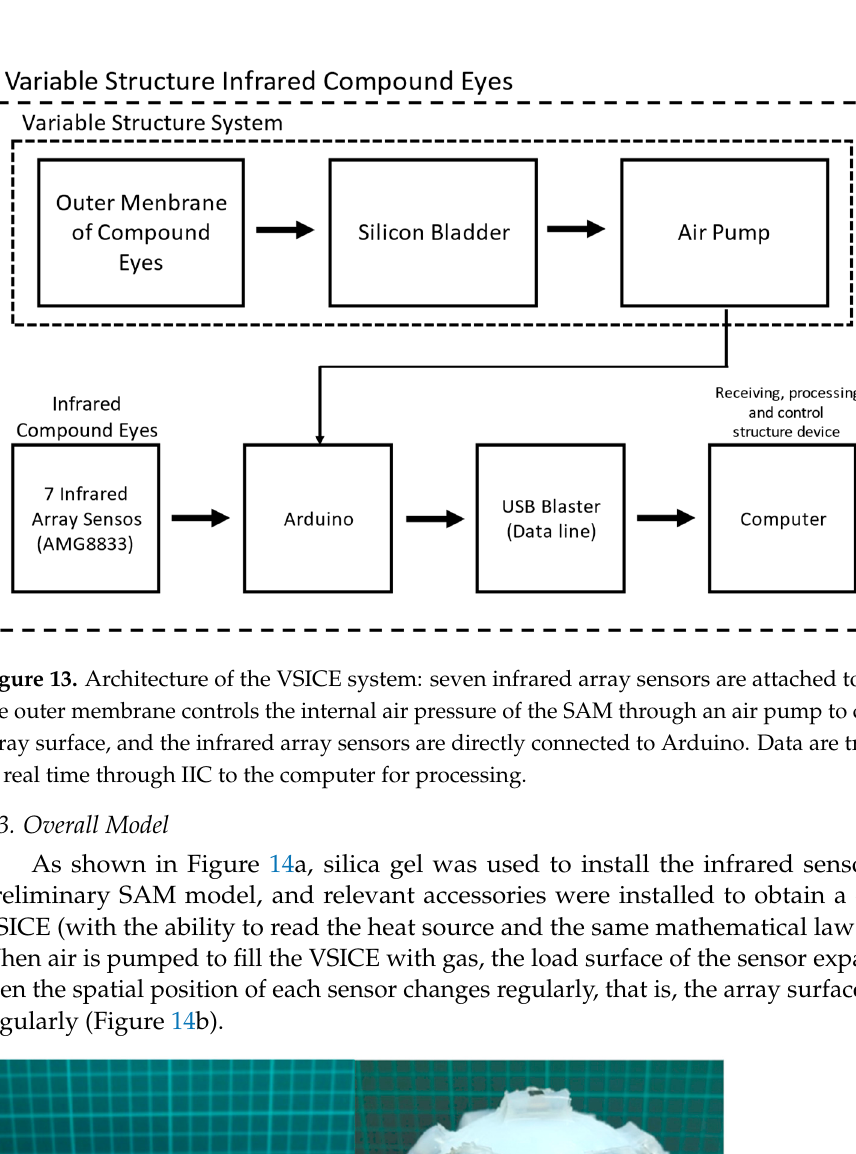
Figure 13. Architecture of the VSICE system: seven infrared array sensors are attached to the SAM, the outer membrane controls the internal air pressure of the SAM through an air pump to change the array surface, and the infrared array sensors are directly connected to Arduino. Data are transmitted in real time through IIC to the computer for processing.